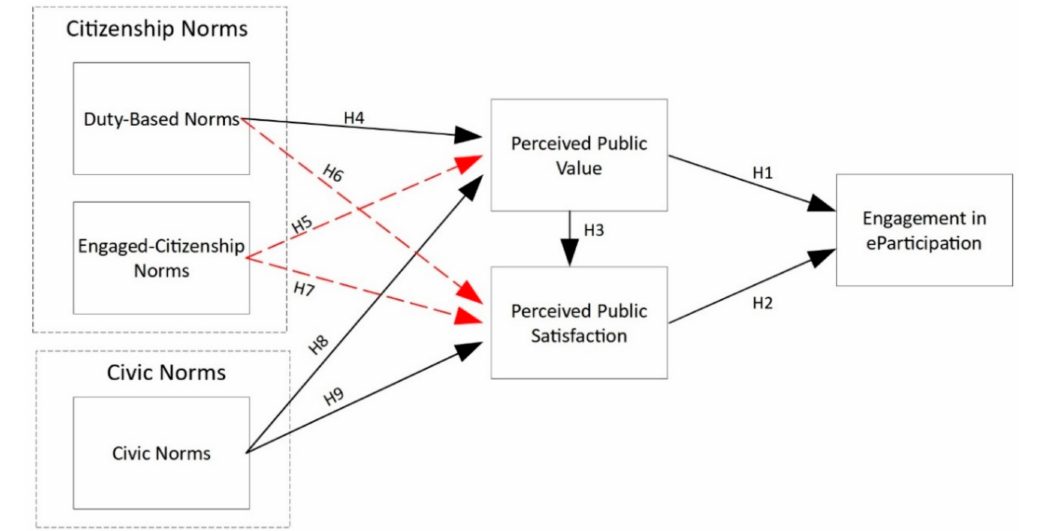
Figure 2. Resulting Model. The red dotted arrows represent non-supported hypotheses. The black solid arrows represent supported